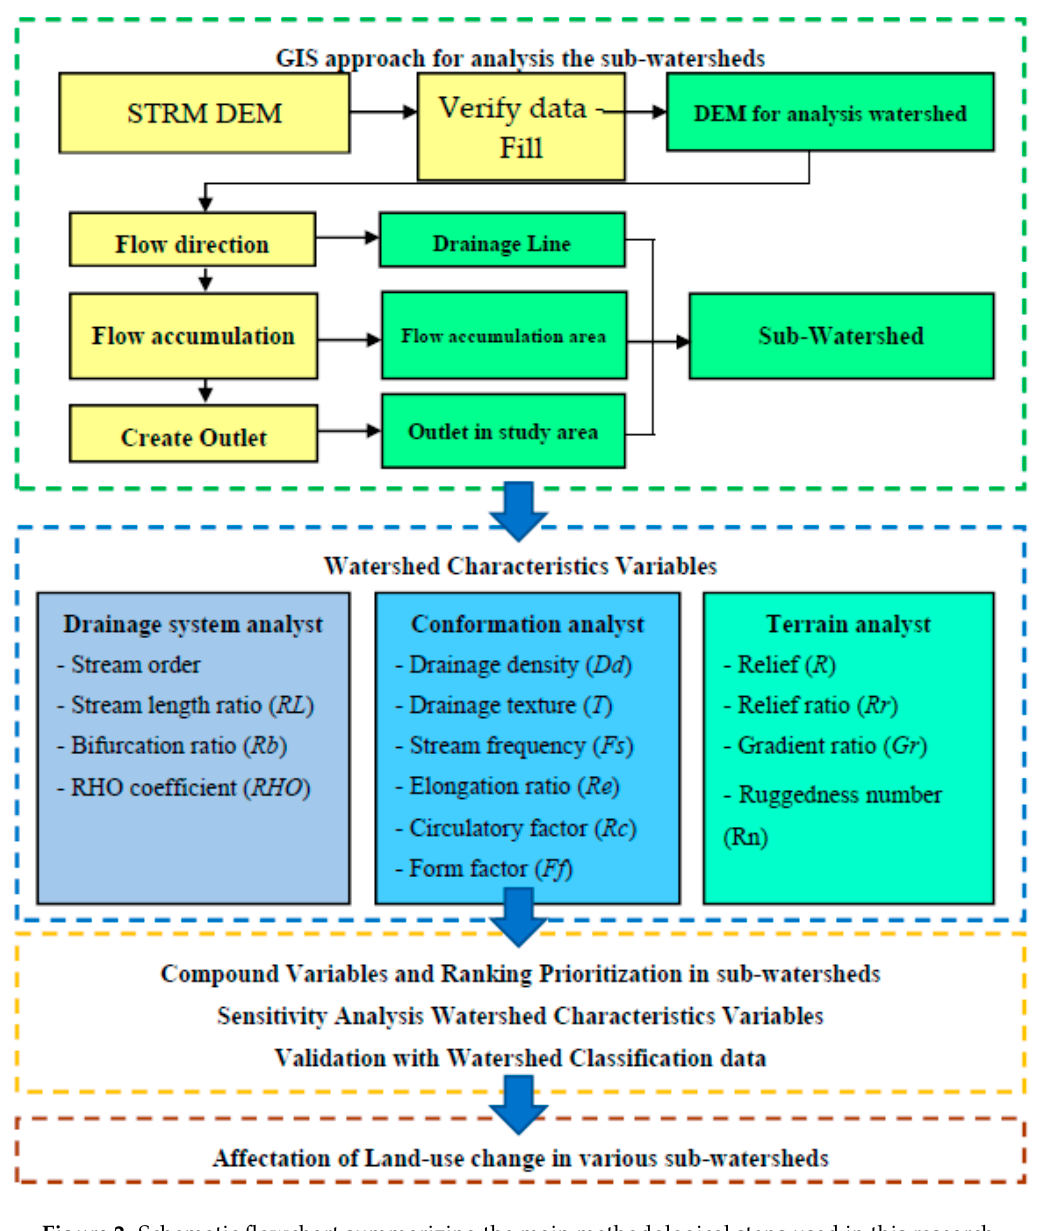
Figure 2. Schematic flowchart summarizing the main methodological steps used in this research .